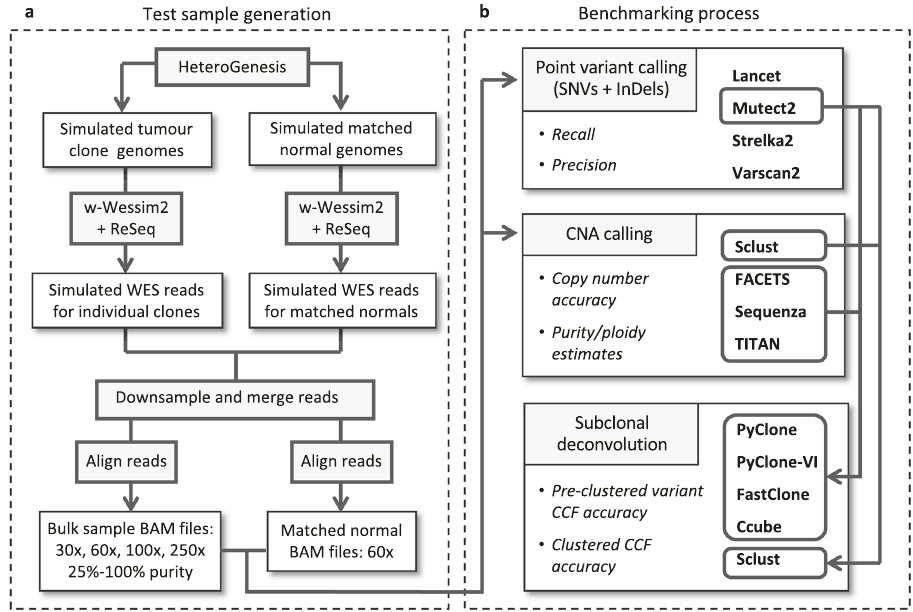
Fig. 2 Test sample generation and benchmarking processes. a Replicate tumour, and matched normal, genomes were simulated using HeteroGenesis according to the parameter sets outline in Fig. 1. In silico WES data was created with w-Wessim2, with errors incorporated via ReSeq. Reads were downsampled and merged to create bulk tumour sequencing data with varying purity and mean sequencing depths, before being aligned. b Bulk tumour and matched normal alignments were used as input for somatic point mutation and copy number callers. Calls from the top performing point mutation caller, Mutect2, were combined with output from all four copy number callers and input to fi ve subclonal deconvolution methods. Sclust performs both copy number calling and subclonal deconvolution and is therefore not tested with outputs from other copy number callers. The metrics used to assess the performance of each algorithm is in italics. CNA copy number alteration, SNV single-nucleotide variation, CCF cancer cell